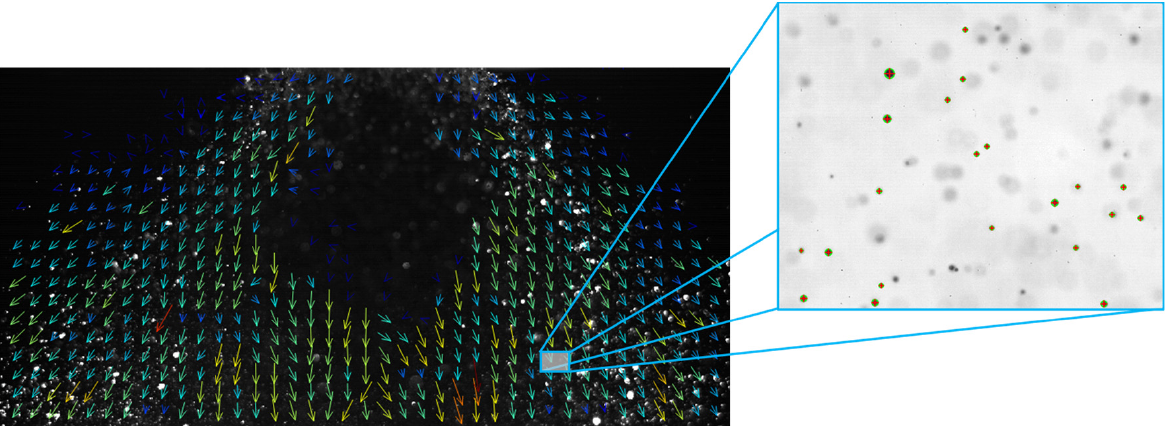
Figure 10. An example of PIV measurements in a cone spray. Inset shows the example of high- resolution droplet imaging using ST method for the same spray.